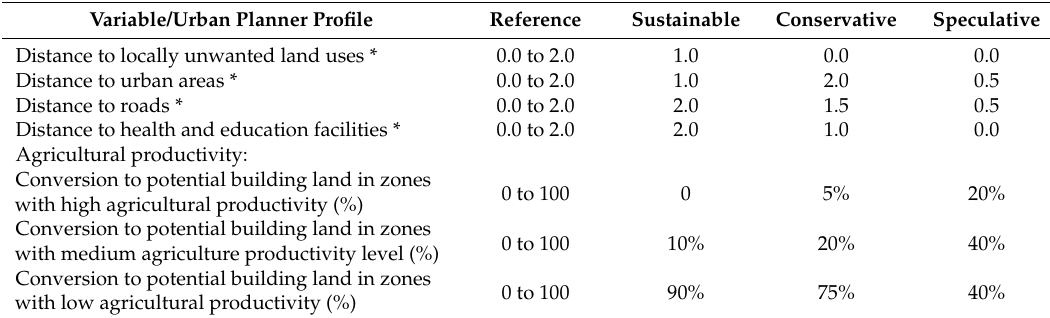
Table 2. Initial conditions for three different urban planner profiles.